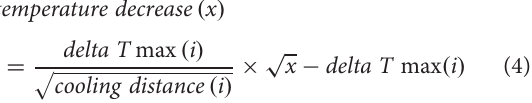
Figure S2.2 also indicates the cooling effects of a 1 km 2 -park surrounded by four high-density blocks and a 1 km 2 -park surrounded by three high-density blocks, and one low-density block. The latter makes a slightly larger green patch due to